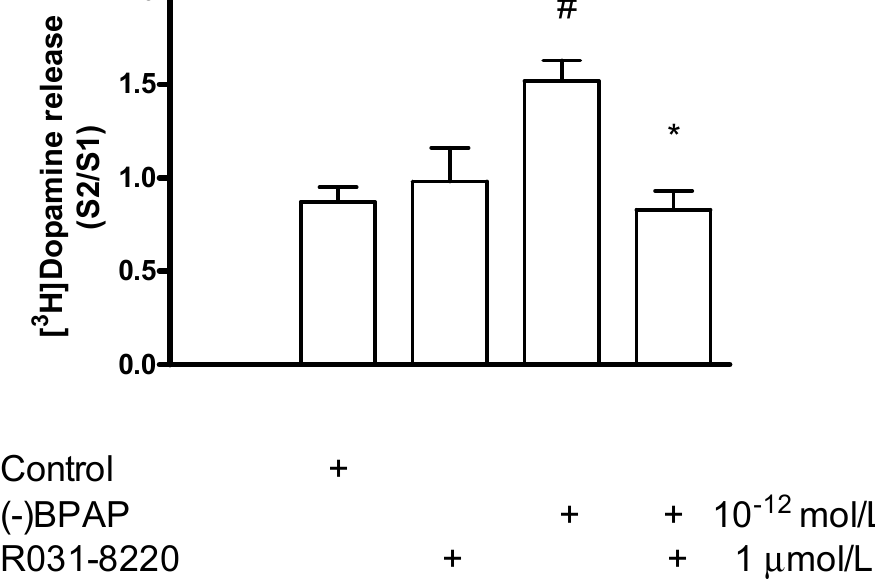
Figure 15. Ro31-8220 reversed ( − )BPAP-induced [ 3 H]dopamine release in rat striatum. For the experimental procedure, see Figure 2A. ( − )BPAP was added to striatal slices from fraction 8 in a concentration of 10 − 12 mol/L in the presence and absence of Ro31-8220. When used, Ro31-8220 was added to striatal slices from fraction 1 in a concentration of 1 µ mol/L and drugs were maintained throughout the experiment. One-way ANOVA followed by the Dunnett’s test, F(3,21) = 9.235, p < 0.001, control vs. ( − )BPAP effect # p < 0.05. Student t -statistics for two-means, ( − )BPAP vs. ( − )BPAP plus Ro31-8220 effect * p = 0.001, mean ± S.E.M., n =